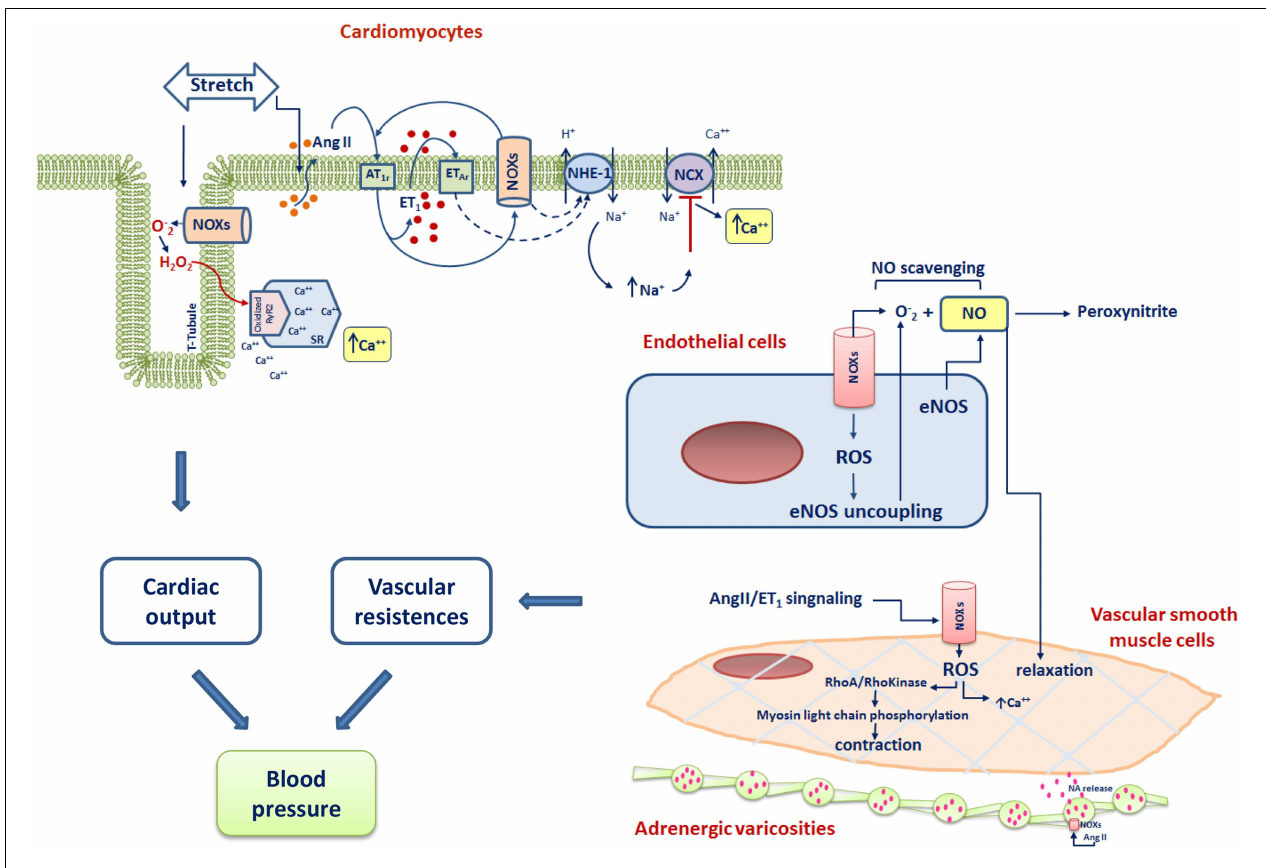
FIGURE 2 | Scheme of the main NOXs-dependent cardiovascular mechanisms involved in the control of blood pressure. RyR2, Ryanodine Receptor type 2; ET-1, endothelin-1; NA, noradrenaline; AT 1 r,